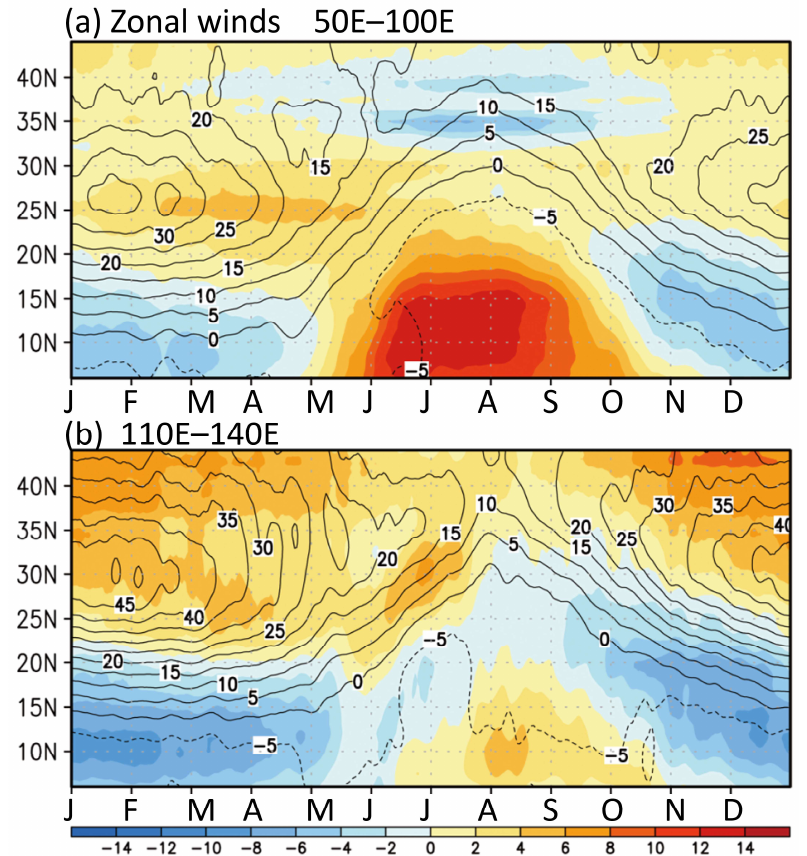
Figure 3. Latitude–time cross sections of zonal winds (m s −1 ) at 850 hPa (color shadings) and averaged Figure 3. Latitude-time cross sections of zonal winds (m s − 1 ) at 850 hPa (color shadings) and averaged within 200–500 hPa (contour lines) over the regions, ( a ) 50° E–100° E and ( b ) 110° E–140° E. within 200–500 hPa (contour lines) over the regions, ( a ) 50 ◦ E–100 ◦ E and ( b ) 110 ◦ E–140 ◦